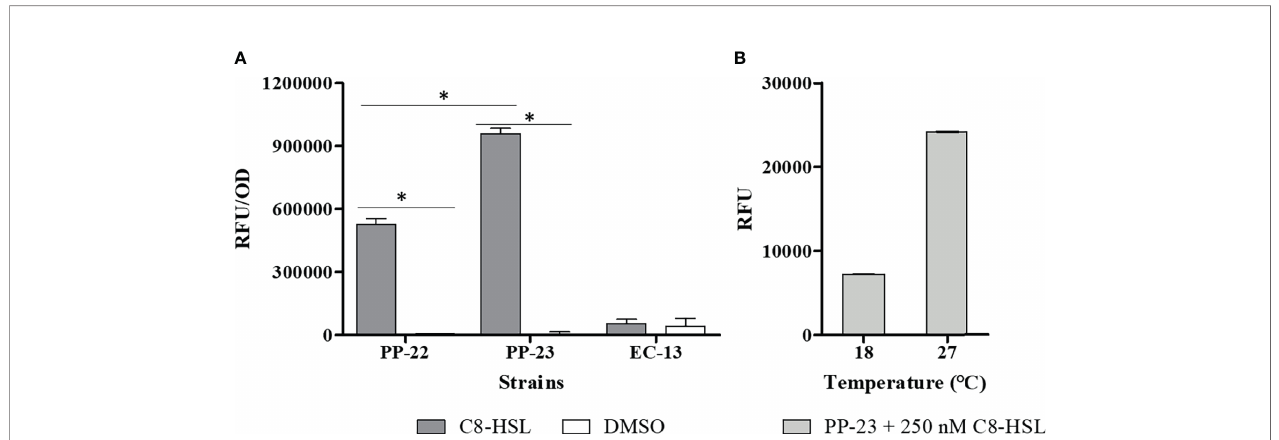
FIGURE 1 | Selection of biosensor strains at the optimal growth conditions of P. salmonis . (A) Response of 4 m M C8-HSL to biosensor strains; PP-22: P. putida EL105 (RPL4las), PP-23: P. putida EL106 (RPL4cep), and EC-12: E. coli MT102 (pKR-C12) at 27°C for 24 h. Control: DMSO (C8-HSL solvent). (B) Response of 250 nM C8-HSL to P. putida EL 106 (RPL4cep) at 18°C and 27°C for 24 h. Emitted fl uorescence was recorded in a microtiter plate reader at 515 nm. RFU, relative fl uorescence units. Asterisks indicate statistical signi fi cance (Student ’ s t-test P ≤ 0.01, n = 3). Error bars: standard